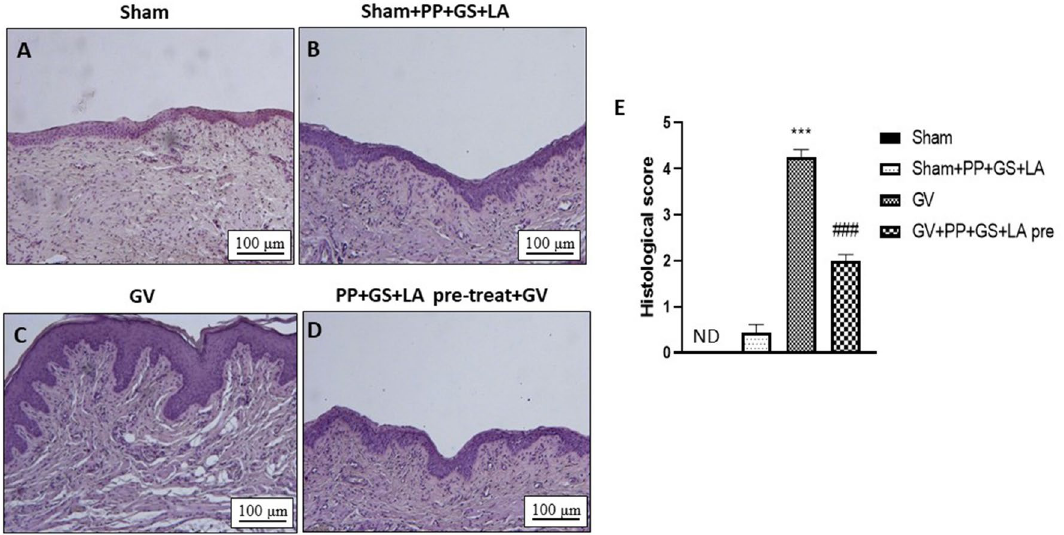
Figure 2. Effect of the product containing PP, GS, and LA on histological damage in pre-treatment condition. The treatment with the product containing PP, GS and LA ( D ) given 1 h before GV infection was able to significantly preserve tissue architecture compared to GV group ( C ). No significance difference was observed in the sham group treated with PP, GS and LA group ( B ) compared to sham group alone ( A ). ( E ) *** p < 0.001 vs Sham; ### p < 0.001 vs GV group.